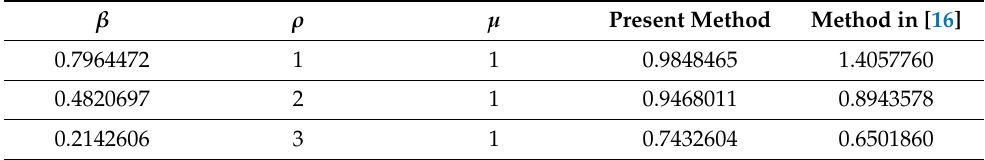
Table 6. Comparison of the effectiveness factor τ with different choices of the